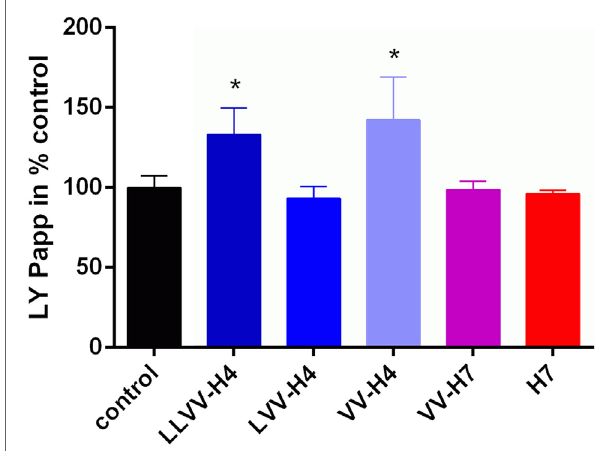
FigUre 5 | Lucifer Yellow (LY) permeability across the blood–brain barrier model in presence of each hemorphin. The marker of paracellular transport LY was applied together with each hemorphin on the apical side of the transwell and its passage into the basolateral chamber was monitored by spectrofluorescence. Collecting basal samples at different time points allowed calculation of the apparent permeability coefficient (Papp) of LY which, when below 1e − 006 cm s − 1 is commonly indicative of the cell barrier